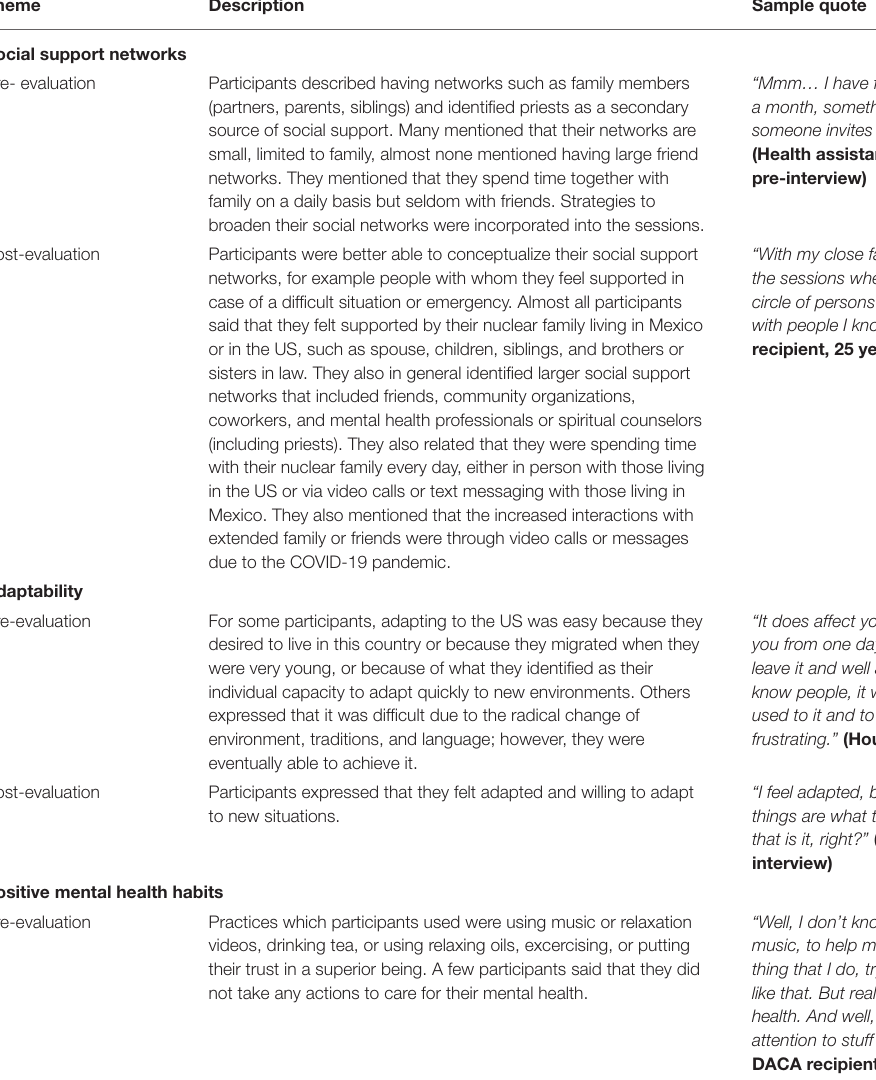
TABLE 3 | Qualitative results for pre- post- evaluation of a mental health promotion intervention for Mexican immigrants. Theme Description Sample